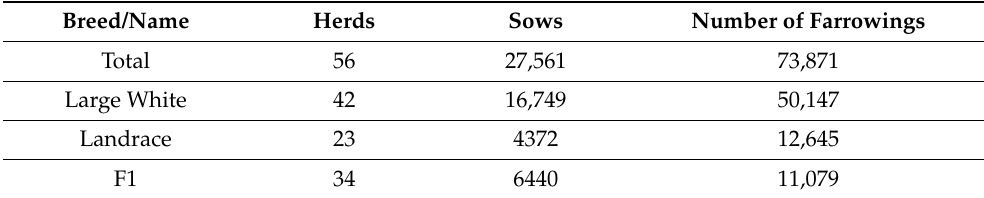
Table 1. Farrowing information 2010–2018. Breed/Name Herds Sows Number of Farrowings Total 56 27,561 Large White